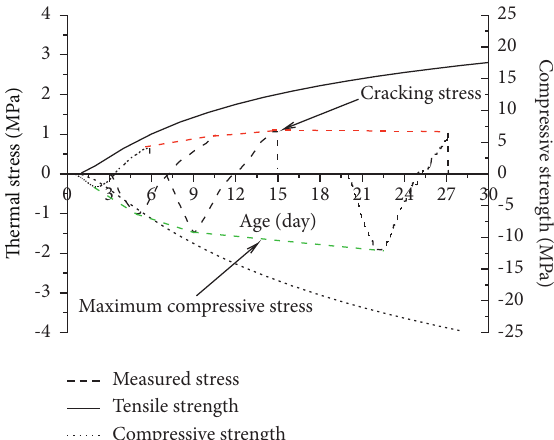
Figure 13: Restrained stress development at different ages.